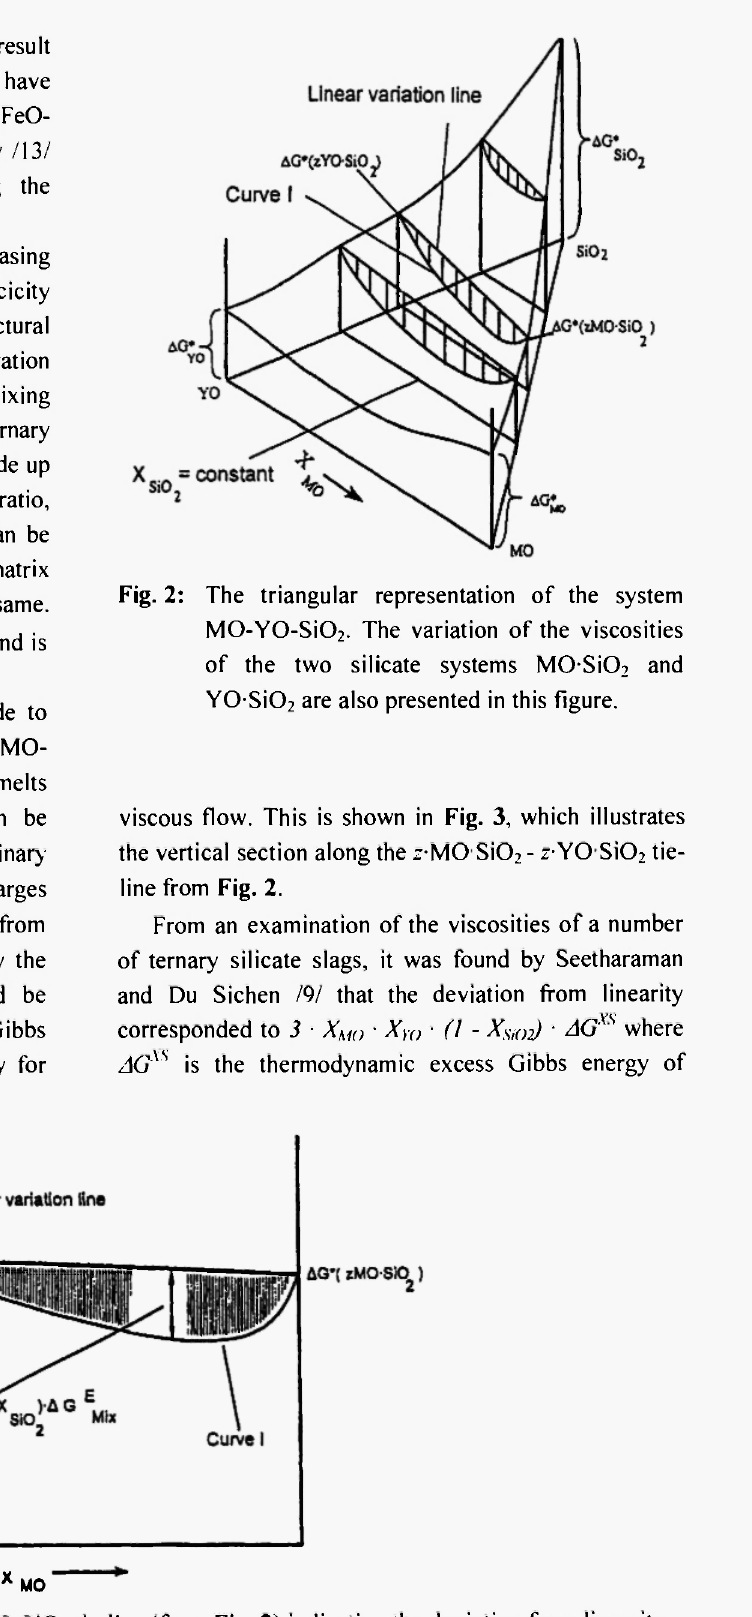
Fig. 3: A vertical section through z M 0 S i 0 2 -zY0-Si0 2 tie-line (from Fig. 2) indicating the deviation from linearity.